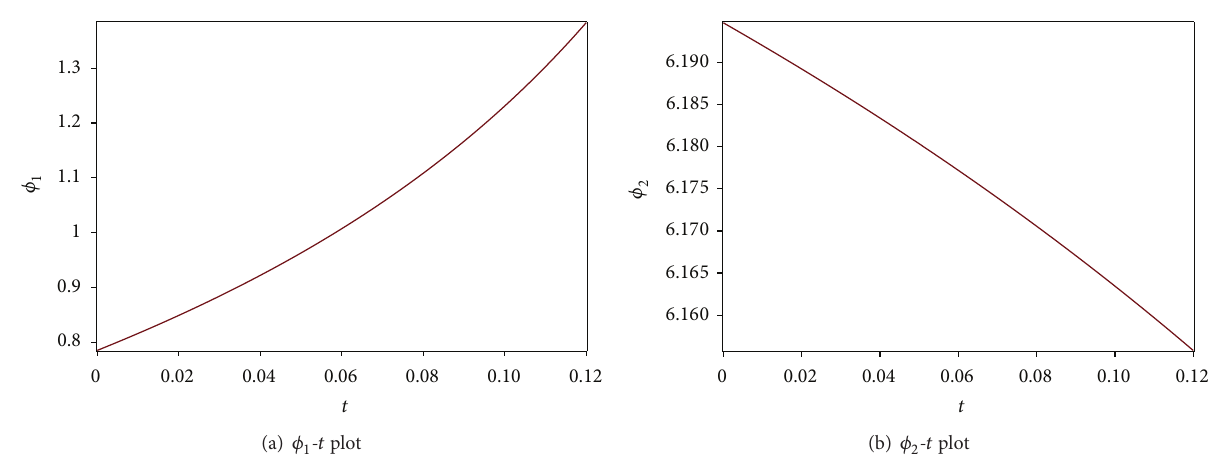
Figure 2: 𝑥 and 𝑦 plots.